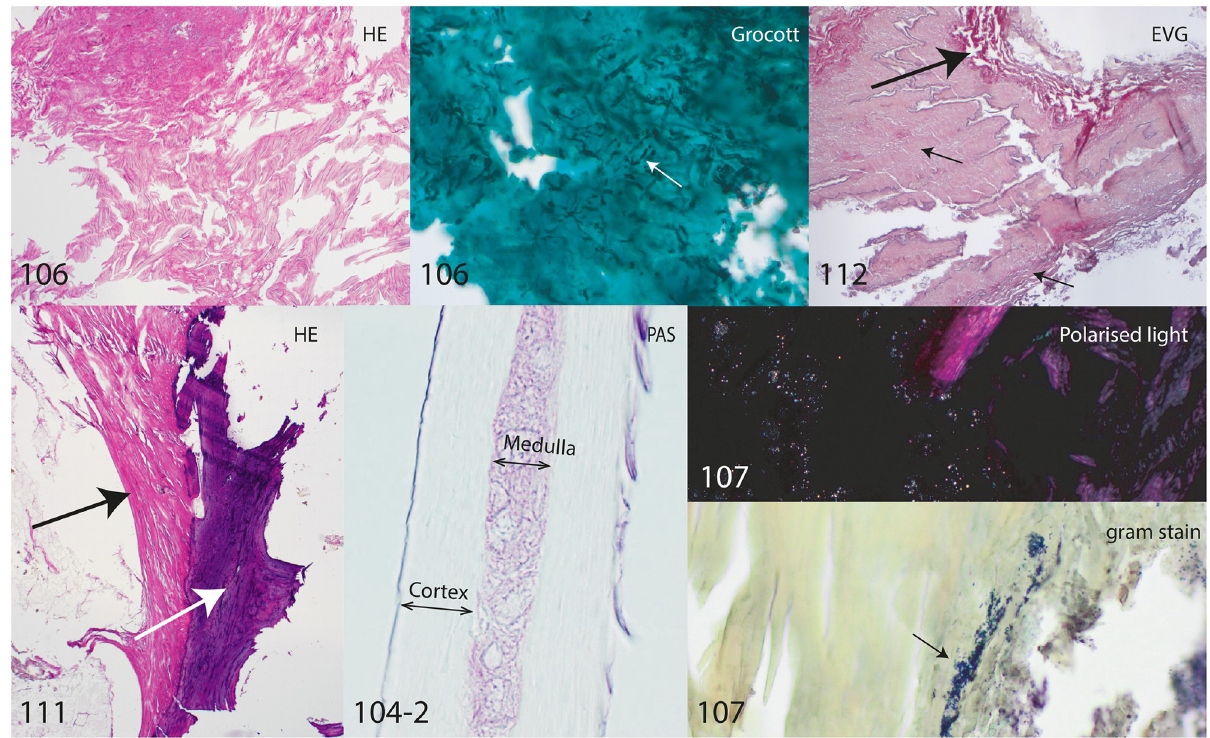
Fig 5. Histology samples of SM1. Sample numbers 106 & 112: Throat area. Note the well-preserved collagen fibers on the HE stain of sample 106. The Grocott stain shows multiple fungi (white arrow). 112: Note the collagen rich perivascular tissue (big arrow) and part of the tunica muscularis of an artery (big arrow). 104–2: Hair. 107: Throat area, the gram stain indicates a high amount of gram positive bacteria (arrow). The polarized light stain indicates crystalline birefringent substance mixed with the tissue. 111: Part of left rib, probably belonging to SM1 with bone (white arrow) and periostal soft tissue (black arrow) with collagen fibers and fatty tissue. Histological staining HE: Hematoxylin and eosin. EVG: Elastica Van Gieson PAS: Periodic acid-Schiff. Grocott: Silver stain for detection of fungi. Gram stain: For detection of